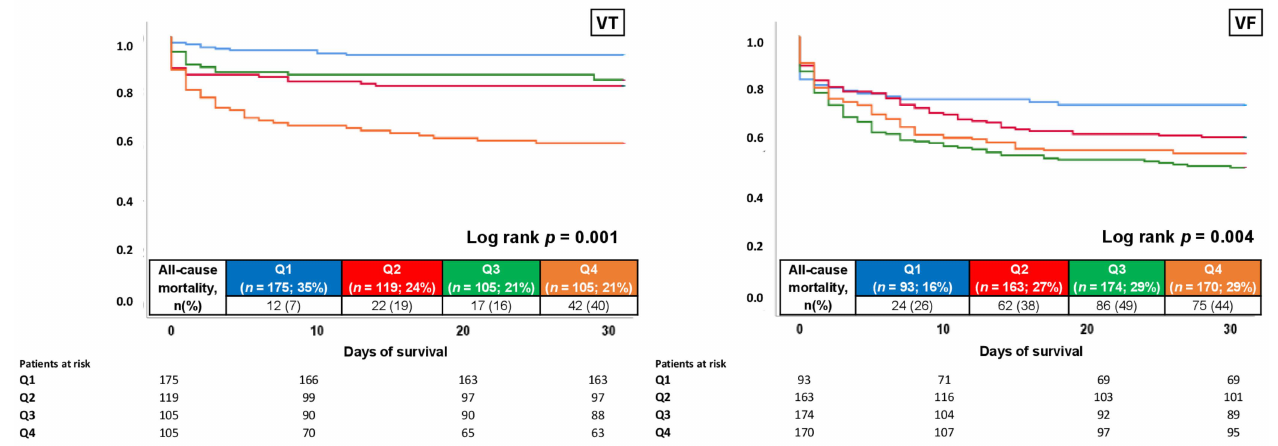
Figure 5. Kaplan–Meier analysis for cTNI with regard to the 30-day all-cause mortality (primary endpoint), stratified by patients with VT ( left panel) and VF ( right panel).